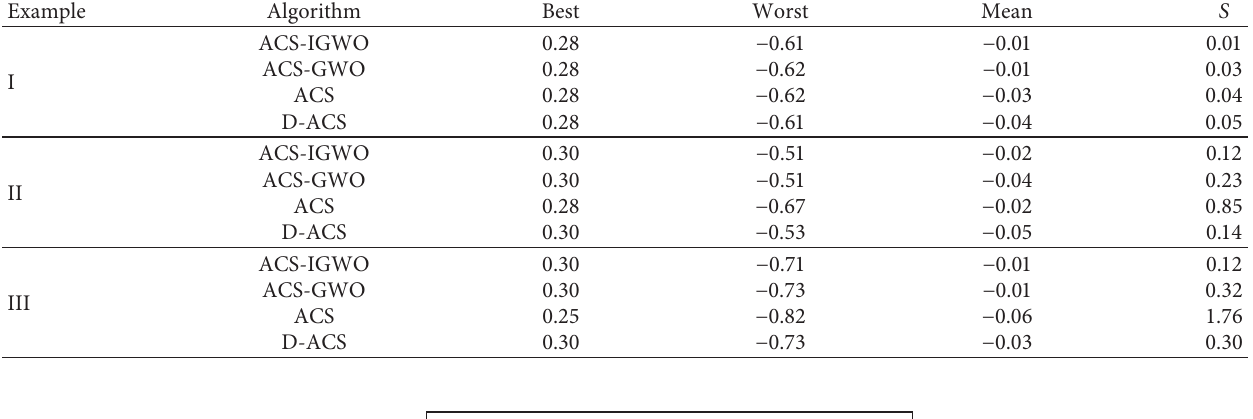
Table 14: Comparison of algorithms of different node cases.